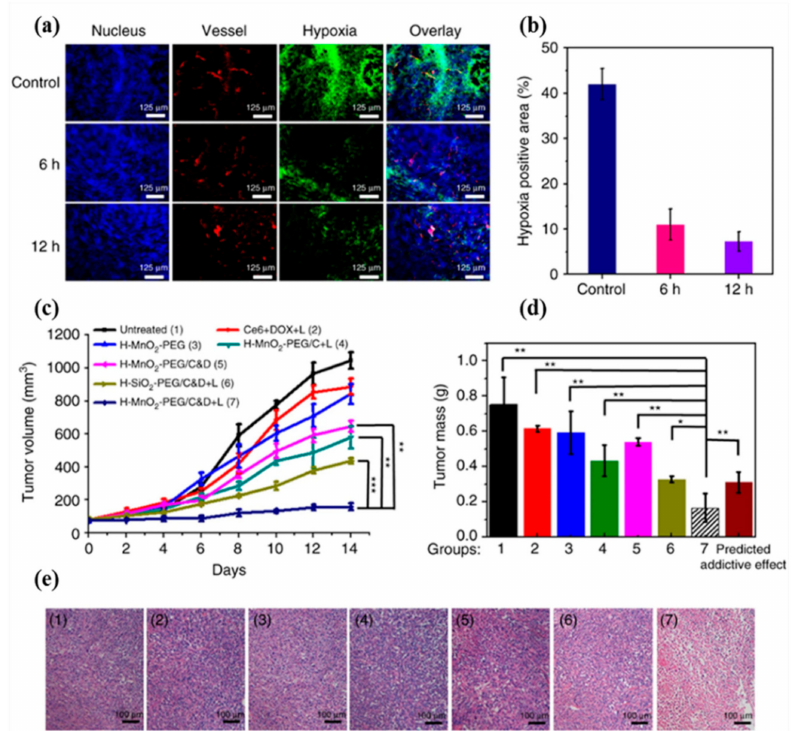
Figure 5. In vivo combined chemo-PDT treatment with H-MnO 2 -PEG/C&D. ( a ) Representative immunofluorescence images of 4T1 tumor slices collected from untreated control mice and mice 6h and 12h post i.v. injection with H-MnO 2 -PEG/C&D. The nuclei, blood vessels, and hypoxic areas were stained with DAPI (blue), anti-CD31 antibody (red), and anti-pimonidazole antibody (green), respectively (three mice per group). ( b ) Quantification of hypoxia areas in tumors at different time points post injection of our NP. ( c ) Tumor growth curves of different groups of mice after various treatments indicated. Error bars were based on standard errors of the mean (SEM) (six mice per group). ( d ) Average weight of tumors collected from mice at day 14 post initiation of various treatments. The predicted addictive effect was calculated by multiplying the tumor growth inhibition ratios of group 4 (PDT alone) and group 5 (chemotherapy alone). ( e ) H&E-stained tumor slices collected from mice post various treatments indicated. p values in ( c , d ) were calculated by Tukey’s post-test (*** p < 0.001, ** p < 0.01, or * p < 0.05). Reproduced with permission [100]. Copyright 2017, Nature publishing